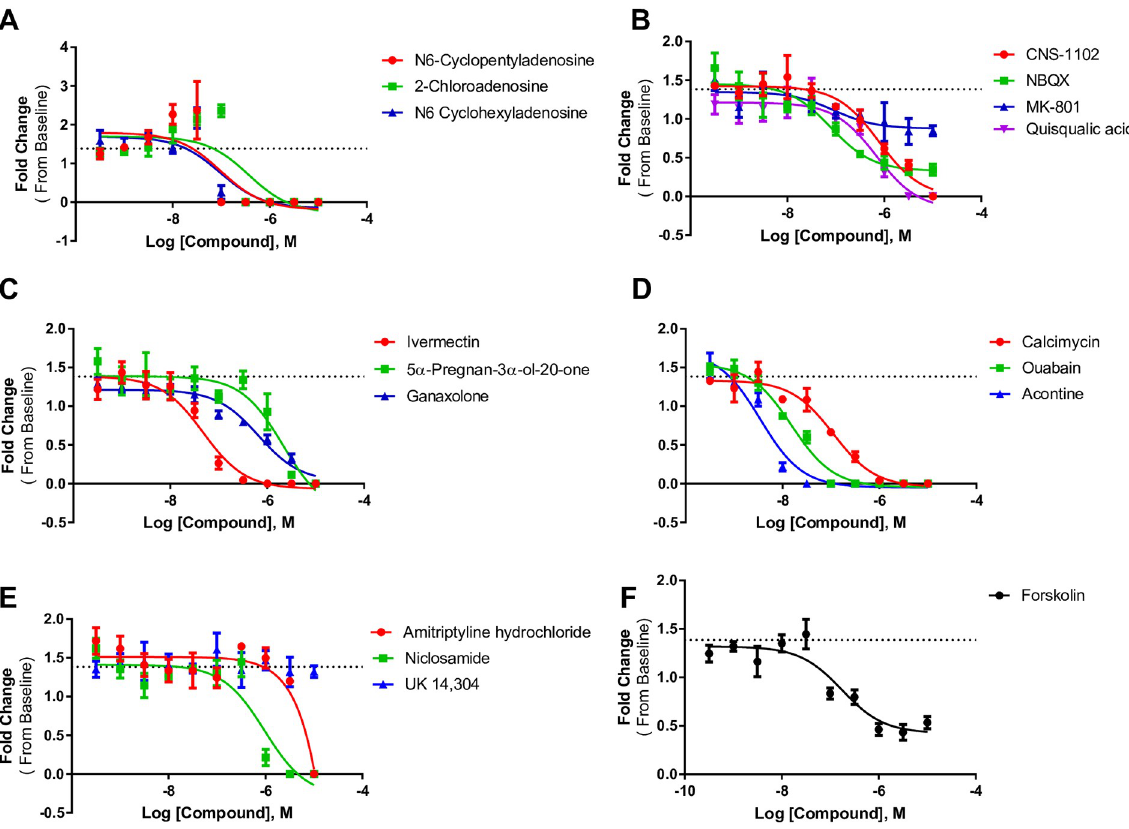
Fig 6. Concentration response curves of peak amplitude. A) Adenosine receptor agonists, B) glutamate receptor compounds, C) GABA receptor compounds, D) blockers of various channels, E) other compounds, and F) concentration response of forskolin. Each point represents n = 3 wells. The dashed line on each graph represents the average of the DMSO-treated wells.